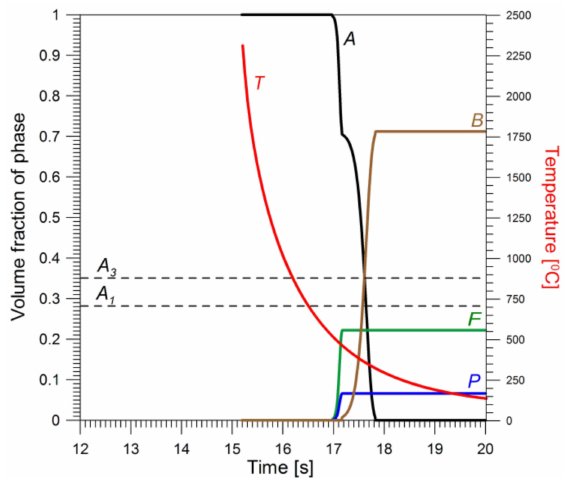
Figure 12. Thermal history at point 1 : T —temperature; A , B , F , P —volume fractions of austenite, bainite, ferrite and pearlite, respectively.